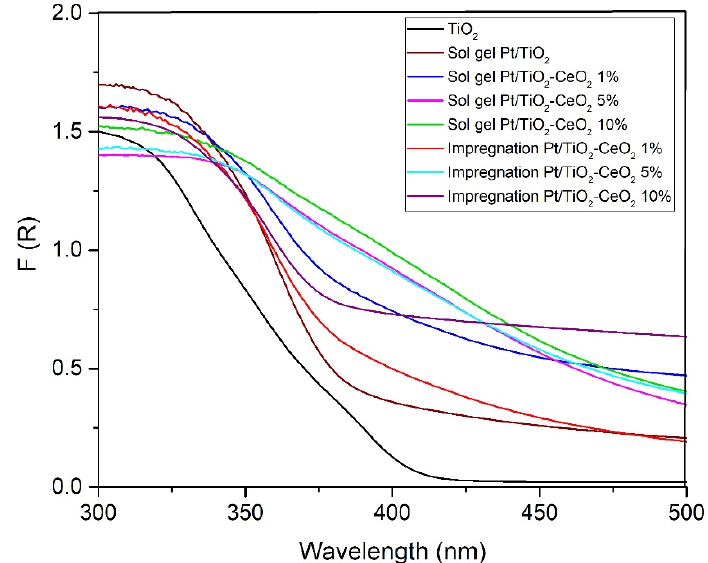
Figure 6. UV–vis spectra for the TiO 2 -CeO 2 supports Sol-Gel and Impregnation. Table 2. Binding energy and relative abundance of the different species obtained by XPS of the catalysts.